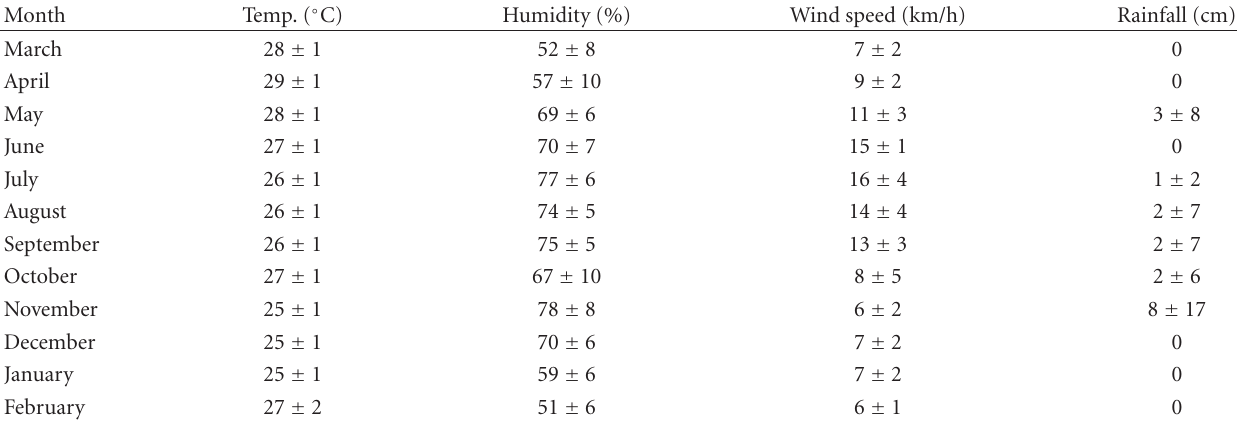
Table 1: Meteorological conditions in Coimbatore during the study period 1